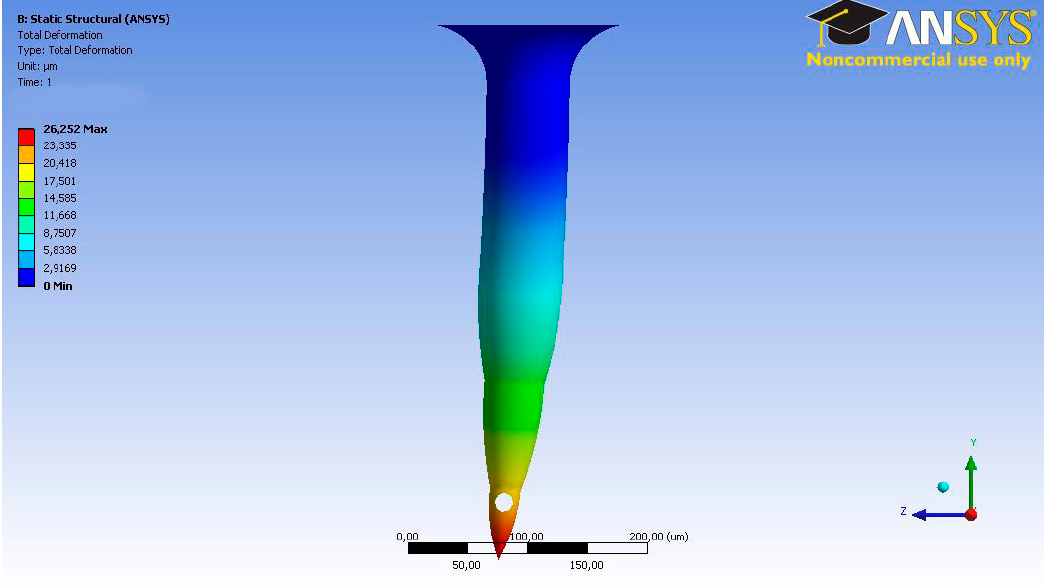
Figure 5. FEA results. Total deformation stresses under axial force for Bee’s sting microneedle.